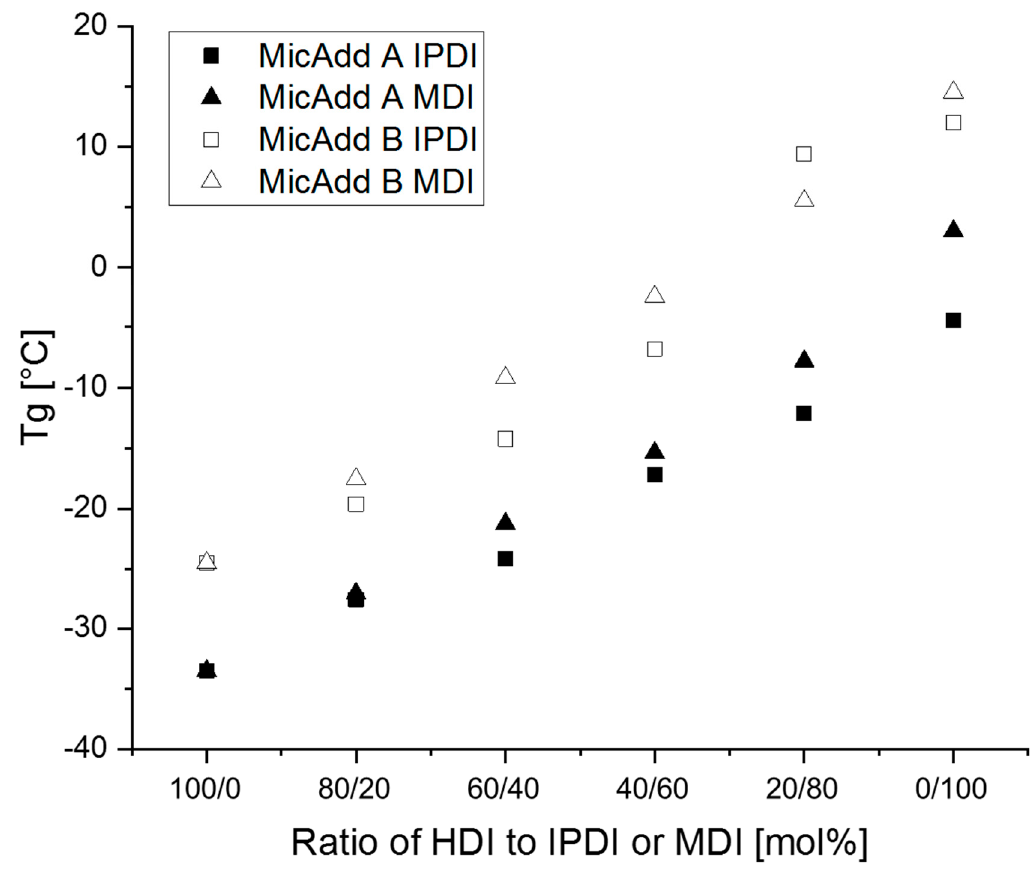
Figure 3. Change of T g by altering ratios of diisocyanates in the reaction mixture.